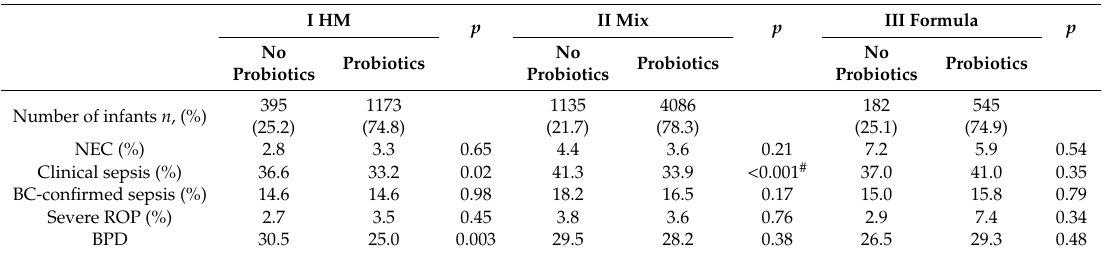
Table 5. Outcomes of the GNN cohort stratified to type of milk feeding and treatment with